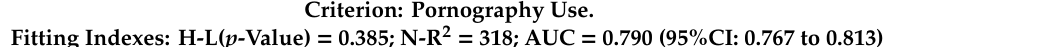
Table 2. Predictive models of pornography use: stepwise logistic regression ( n =